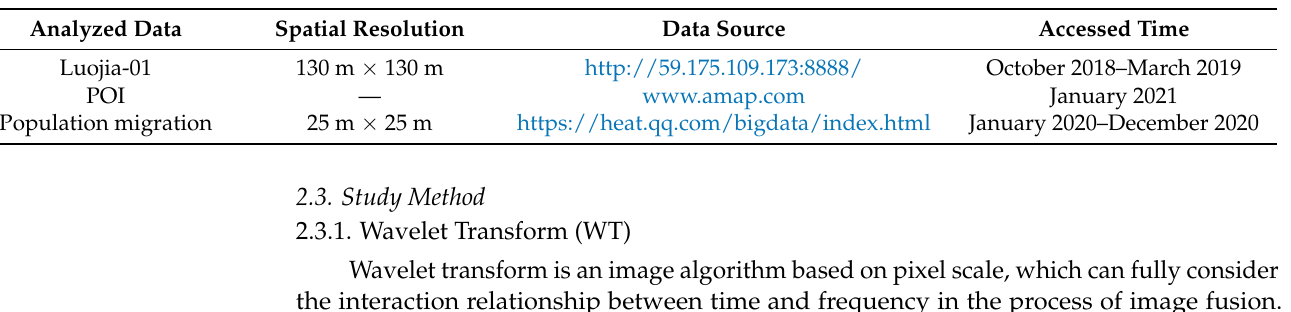
Table 1. Details of analyzed